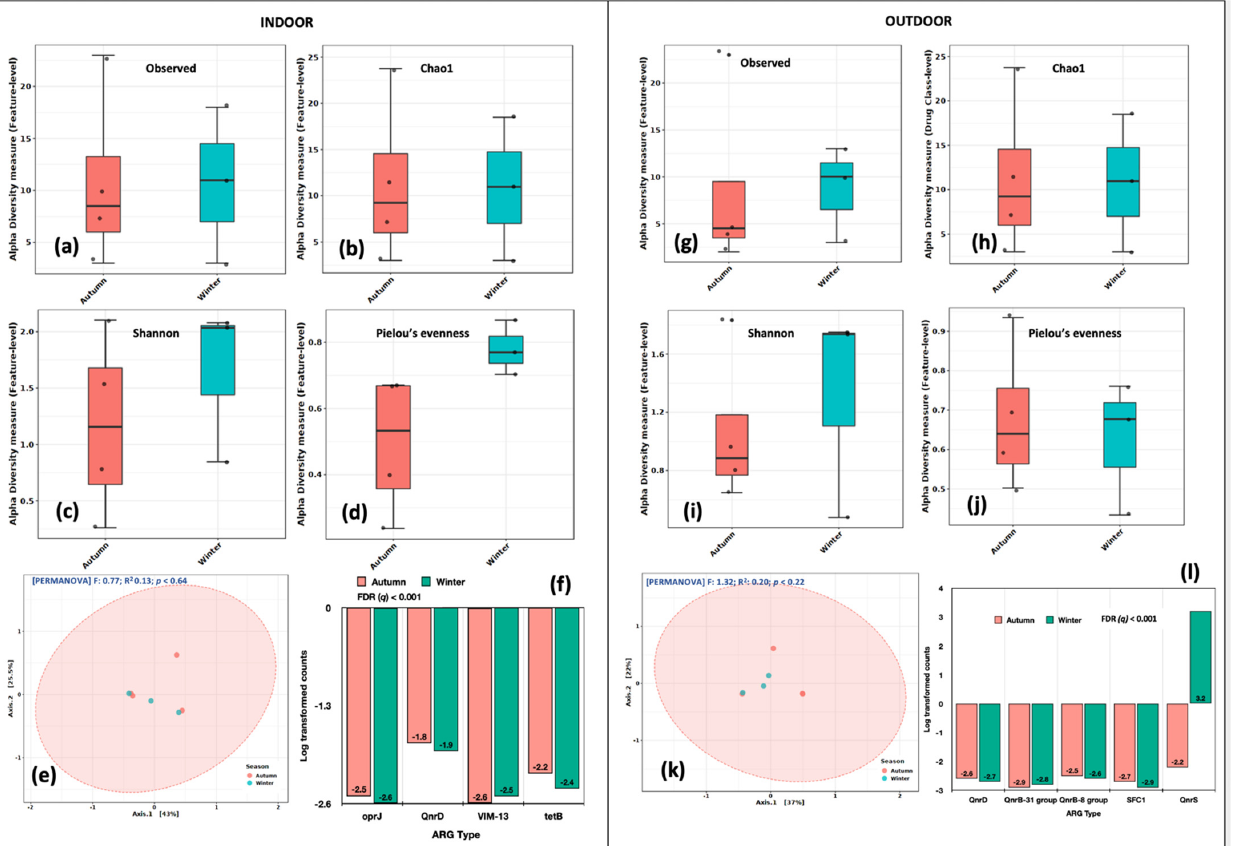
Figure 6. Intra-spatial variations in ARG abundance between autumn and winter seasons. Indoor aerosol alpha diversity analysis: ( a ) Observed features, ( b ) Chao1 indices, ( c ) Shannon’s evenness and richness, ( d ) Pielou’s evenness index. Beta diversity analysis: ( e ) Principal coordinate analysis (PCoA) on Bray Curtis distances through Ward algorithm. Differential abundance testing: ( f ) fitZig model (DESeq2). Outdoor aerosols: ( g ) Observed features, ( h ) Chao1 indices, ( i ) Shannon’s evenness and richness, ( j ) Pielou’s evenness index. Beta diversity analysis: ( k ) Principal coordinate analysis (PCoA) on Bray Curtis distances through Ward algorithm. Di ff erential abundance testing: ( l ) fi tZig model (DESeq2). The green colour in each fi gure represents the indoor samples, whereas the red colour represents outdoor aerosols.